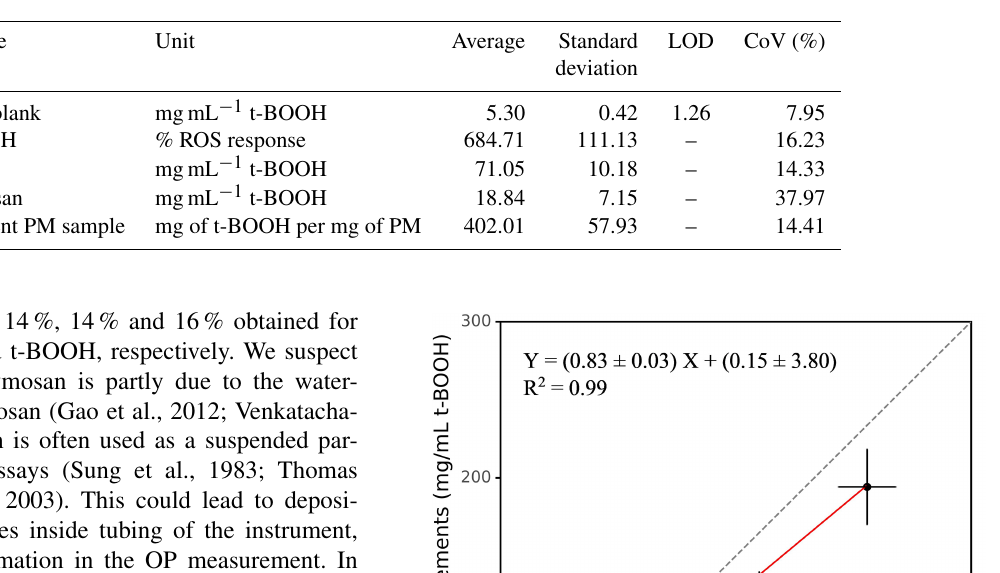
Table 1. Limit of detection and precision of the instrument obtained through the measurements of field blanks, positive control and ambient PM samples ( N = 10).